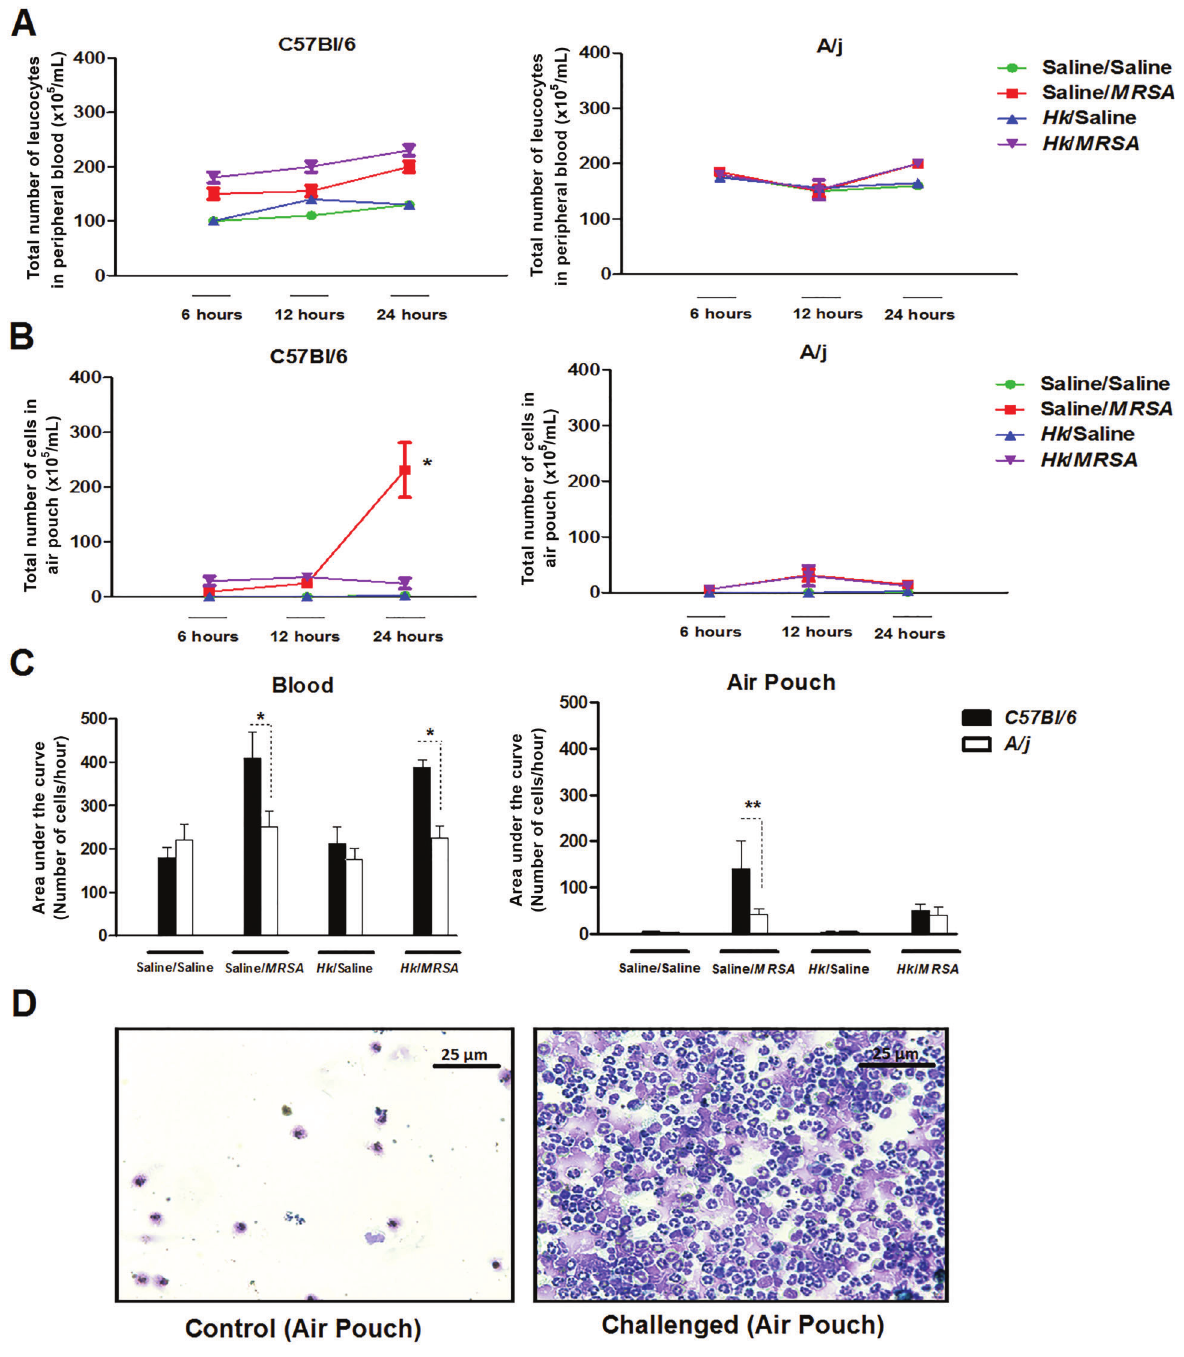
Figure 4. C57BL/6 and A/j mice previously immunized with 10 6 strains of MRSA inactivated by heat were challenged in the air pouch with 10 7 colony forming units (CFU) of live MRSA. A , Number of leukocytes in peripheral blood. B , Number of leukocytes present in the air pouch lavage sample. C , Comparison between the two mouse lineages of the amount of leukocytes present in peripheral blood and in the air pouch lavage. D , Representation of the in fl ammatory in fi ltrate in the air pouch C57BL/6 controls and infected mice (12 h). Bar=25 m M. Data are reported as means ± SD. MRSA: methicillin-resistant Staphylococcus aureus ; Hk: Heat killed. *P o 0.05 (Kruskal-Wallis test and Dunn ’ s post-test; Mann-Whitney test for comparisons between